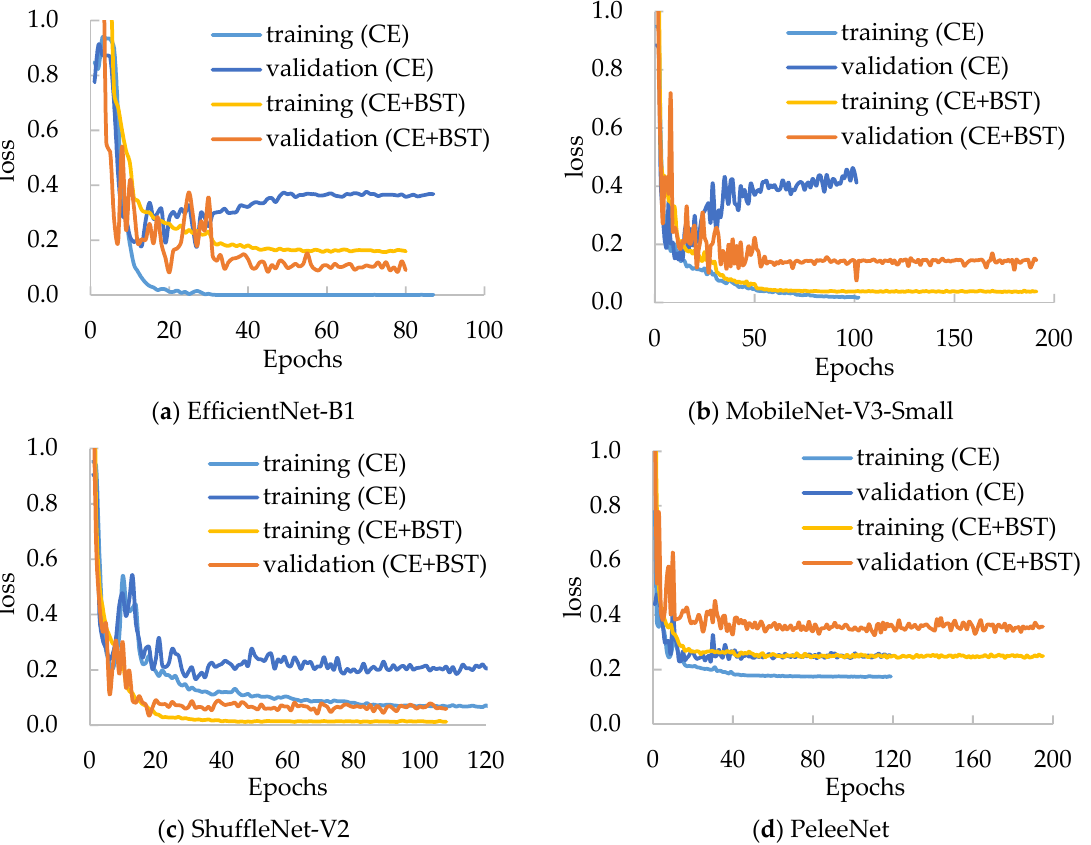
Figure 8. Loss curves for the compared networks on the Chest-1 dataset.